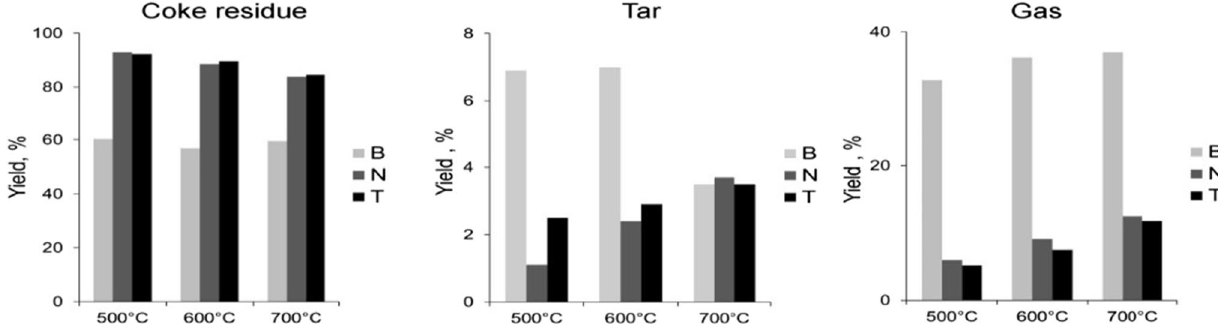
Fig.10 The yields of products from the pyrolysis of coals at different